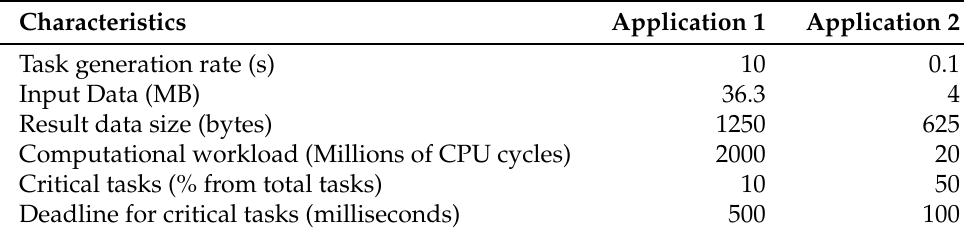
Table 4. Characteristics of chosen